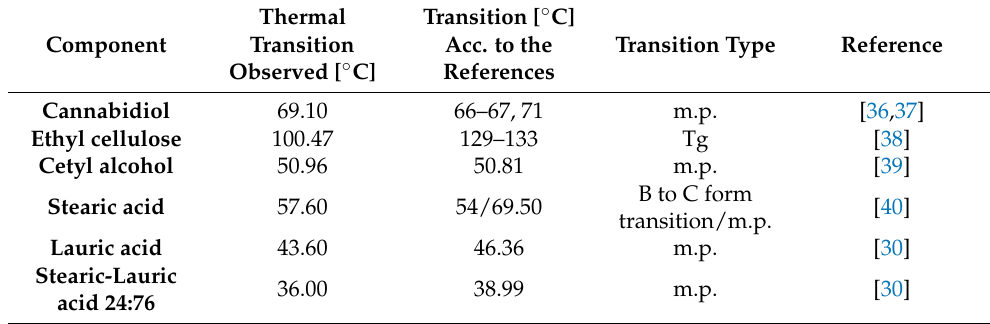
Figure 1. Differential scanning calorimetry profiles of lipid-stabilized nanoparticles and their sourced ingredients. The upper right corner presents the full-range thermogram with mannitol melting peaks at 169 °C. Table 2. Thermal transition parameters of nanoparticle